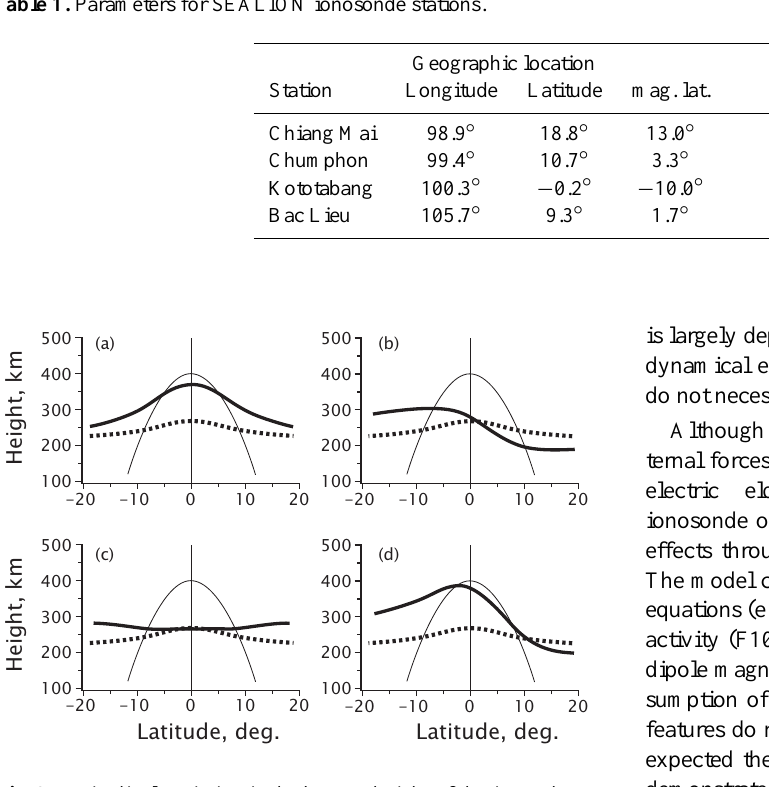
Fig. 3. Latitudinal variation in the bottom height of the ionosphere. In each panel, the dotted line was obtained without external forces and the thin line indicates the magnetic field line across the equa- tor at 400km. The thick lines represent changes in the bottom height caused by an upward E × B drift (a) , a uniform transequato- rial northward wind (b) , a convergence (with respect to the magnetic equator) neutral wind (c) , and a combination of the upward E × B drift and the uniform transequatorial northward wind (d) . The neg- ative sign of the latitude indicates the Southern